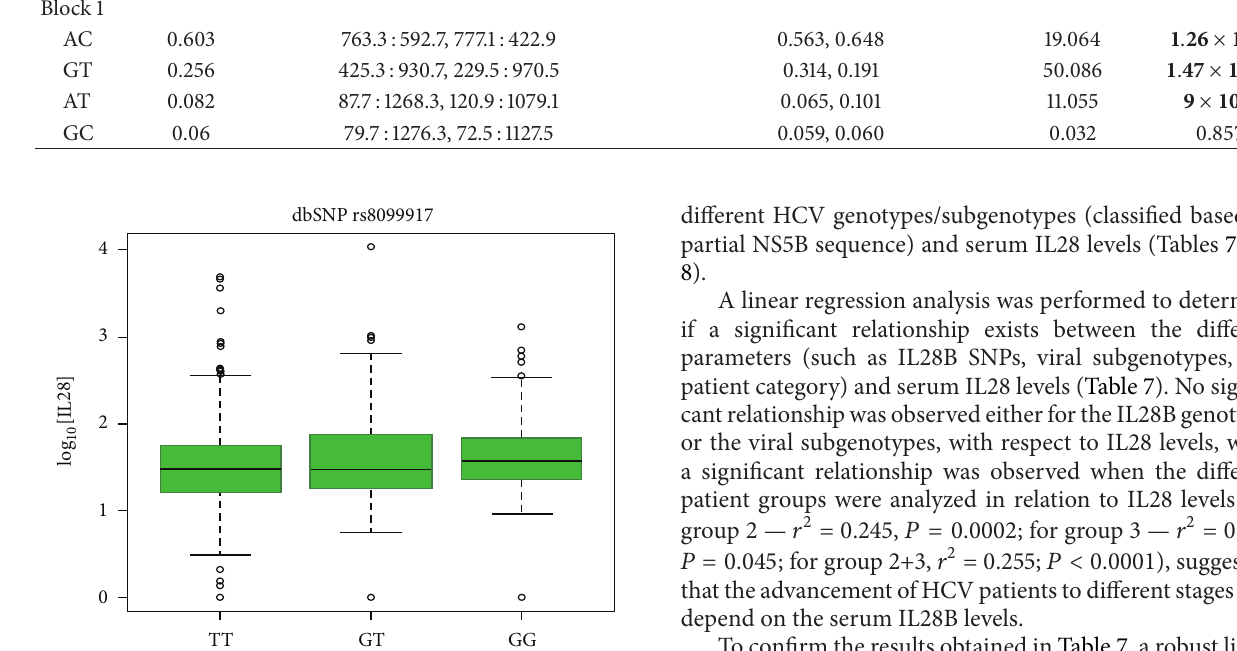
Table 3: Haplotype analysis for SNPs rs12980275 and rs12979860 when patient group (groups “1+2+3”) was compared to control group. Haplotype